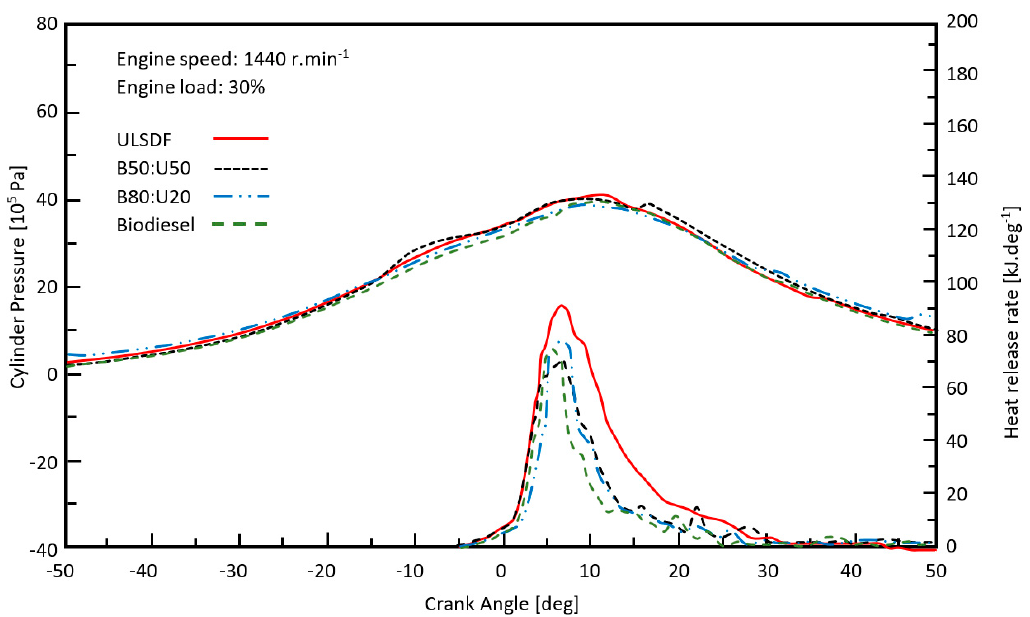
Figure 5. Tested fuels’ influence on the heat release rate and cylinder pressure at 1440 rpm and 30% load .